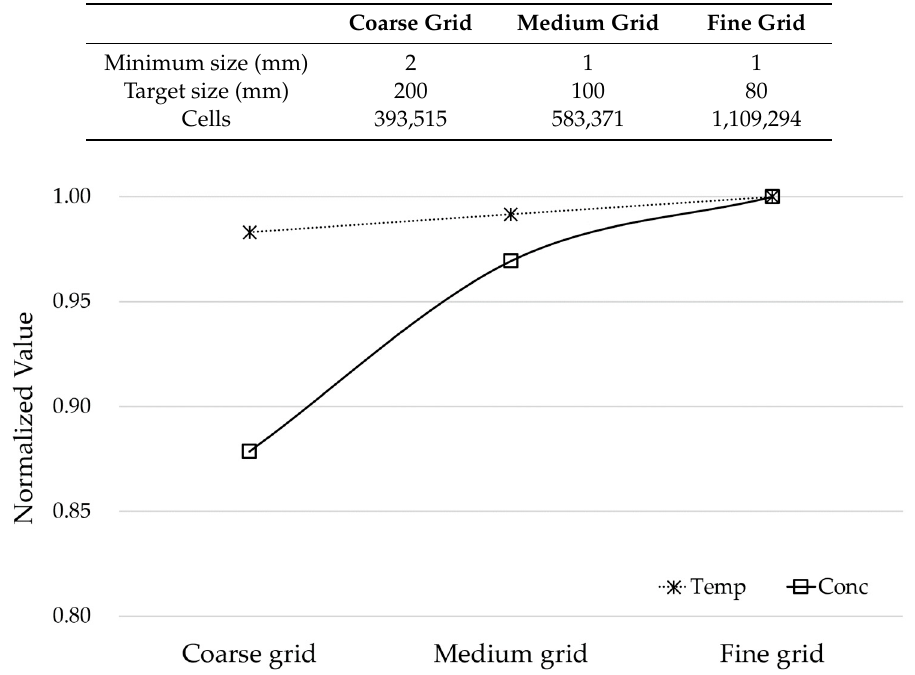
Figure 5. Result of the grid sensitivity analysis.